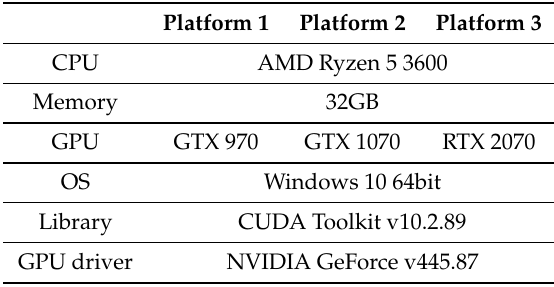
Table 5. Experimental